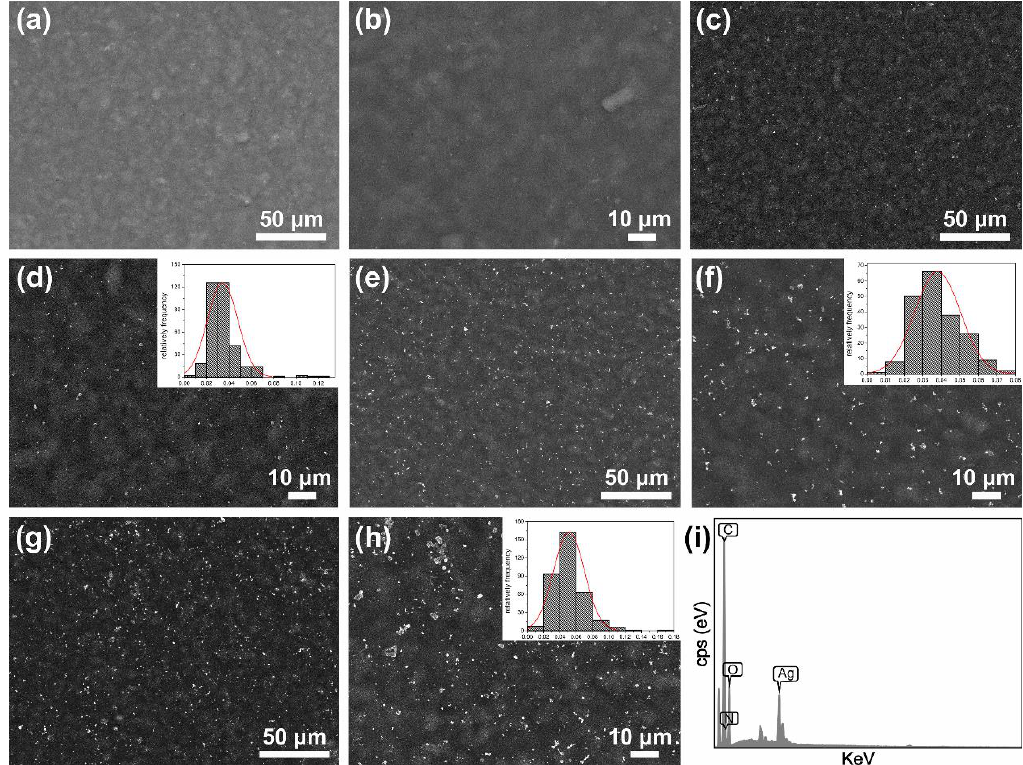
Figure 6. The surface morphology of the different films. The SS/agar film ( a , b ) and AgNPs/SS/agar films after UV irradiation for 10 min ( c , d ), 30 min ( e , f ), and 60 min ( g , h ), respectively; inset in ( d , f , h ): the size distribution of the AgNPs. ( i ) Elemental composition analysis of the AgNPs/SS/agar film by EDS.